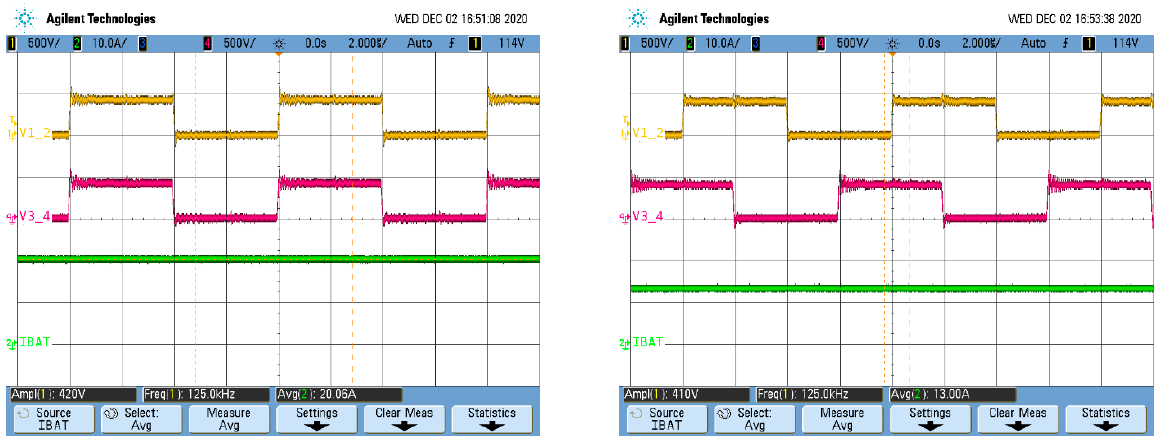
Figure 17. From top to bottom: Midpoint voltages of phases 1 and 2, v 1,2 . Midpoint voltages of phases 3 and 4, v 3,4 . Charging current i Bat . Left: Full load condition ( Ψ 0 = Ψ 1 = Ψ 2 = Ψ 3 = 0°). Right: 70% of full load condition ( Ψ 0 = Ψ 1 = 0°, Ψ 2 = Ψ 3 = 90°).